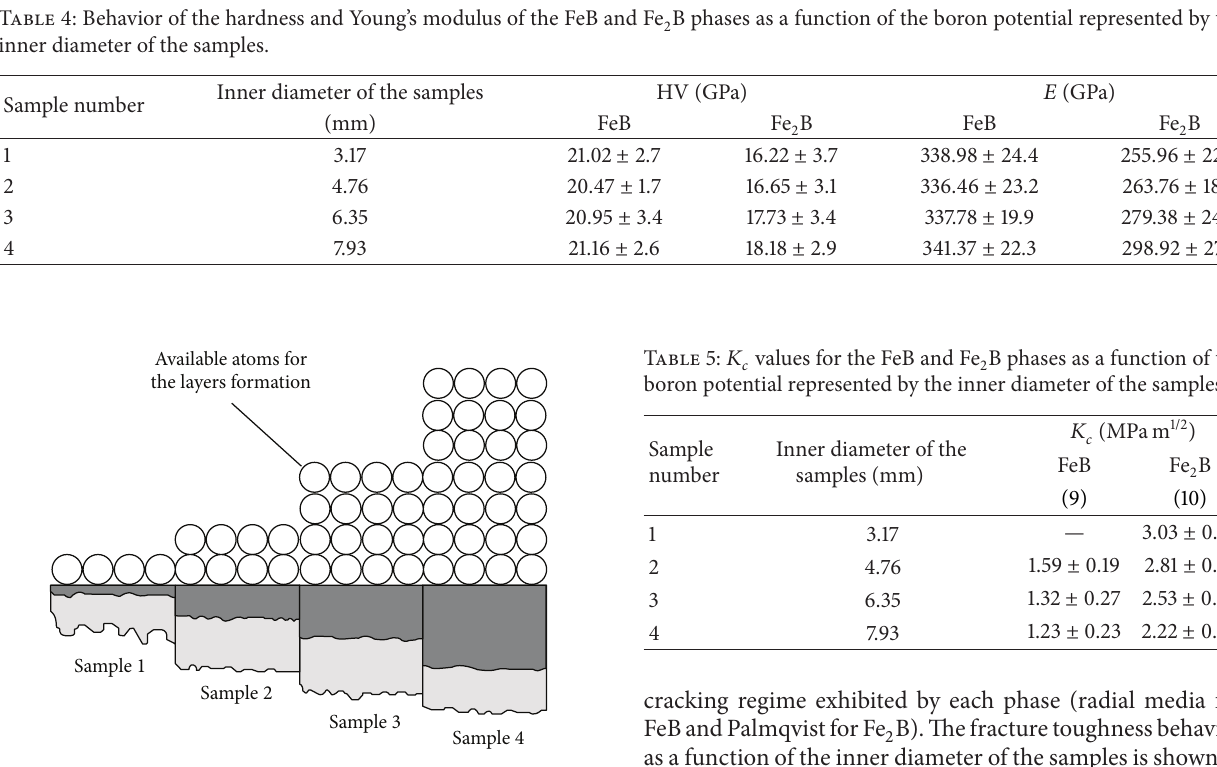
B phases as a function of the boron potential represented by the 2